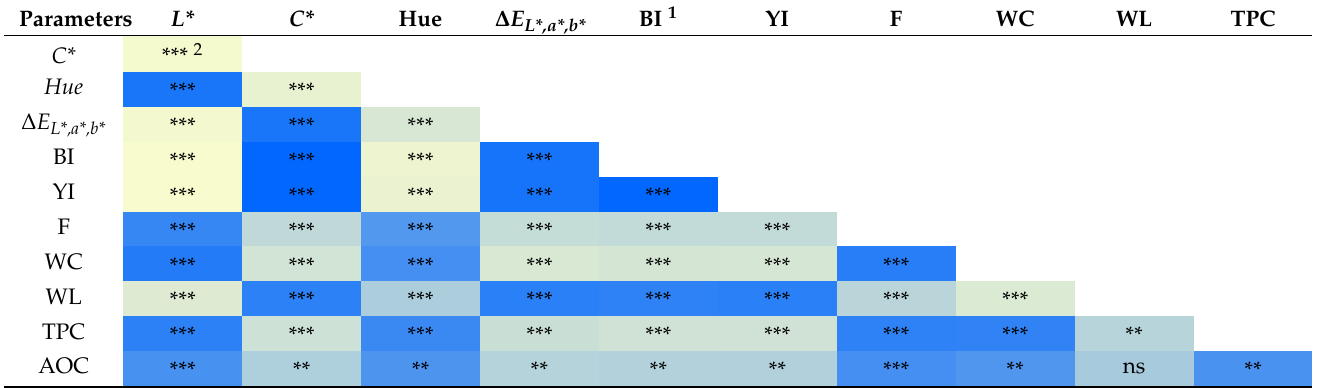
Table 6. Relationships among the quality parameters followed during storage and shelf life periods. Parameters